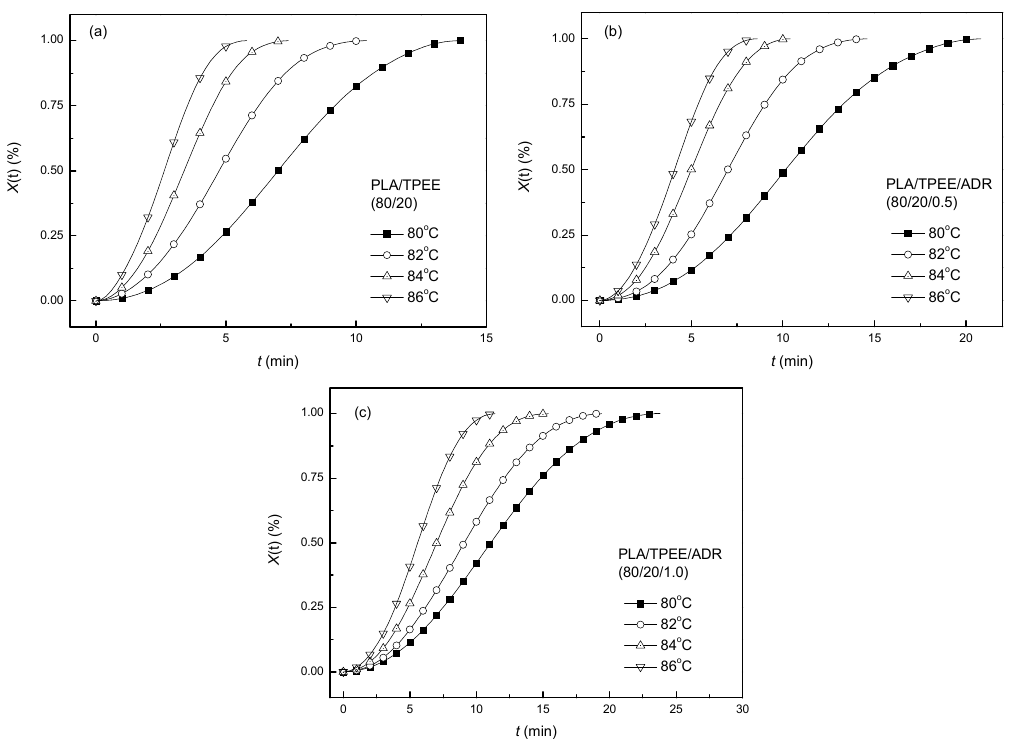
Figure 1. Relative crystallinity ( X (t)) vs. crystallization time ( t ) in the isothermal cold crystallization process for PLA blends: ( a ) PLA/TPEE (80/20); ( b ) PLA/TPEE/ADR (80/20/0.5); ( c ) PLA/TPEE/ADR (80/20/1.0).